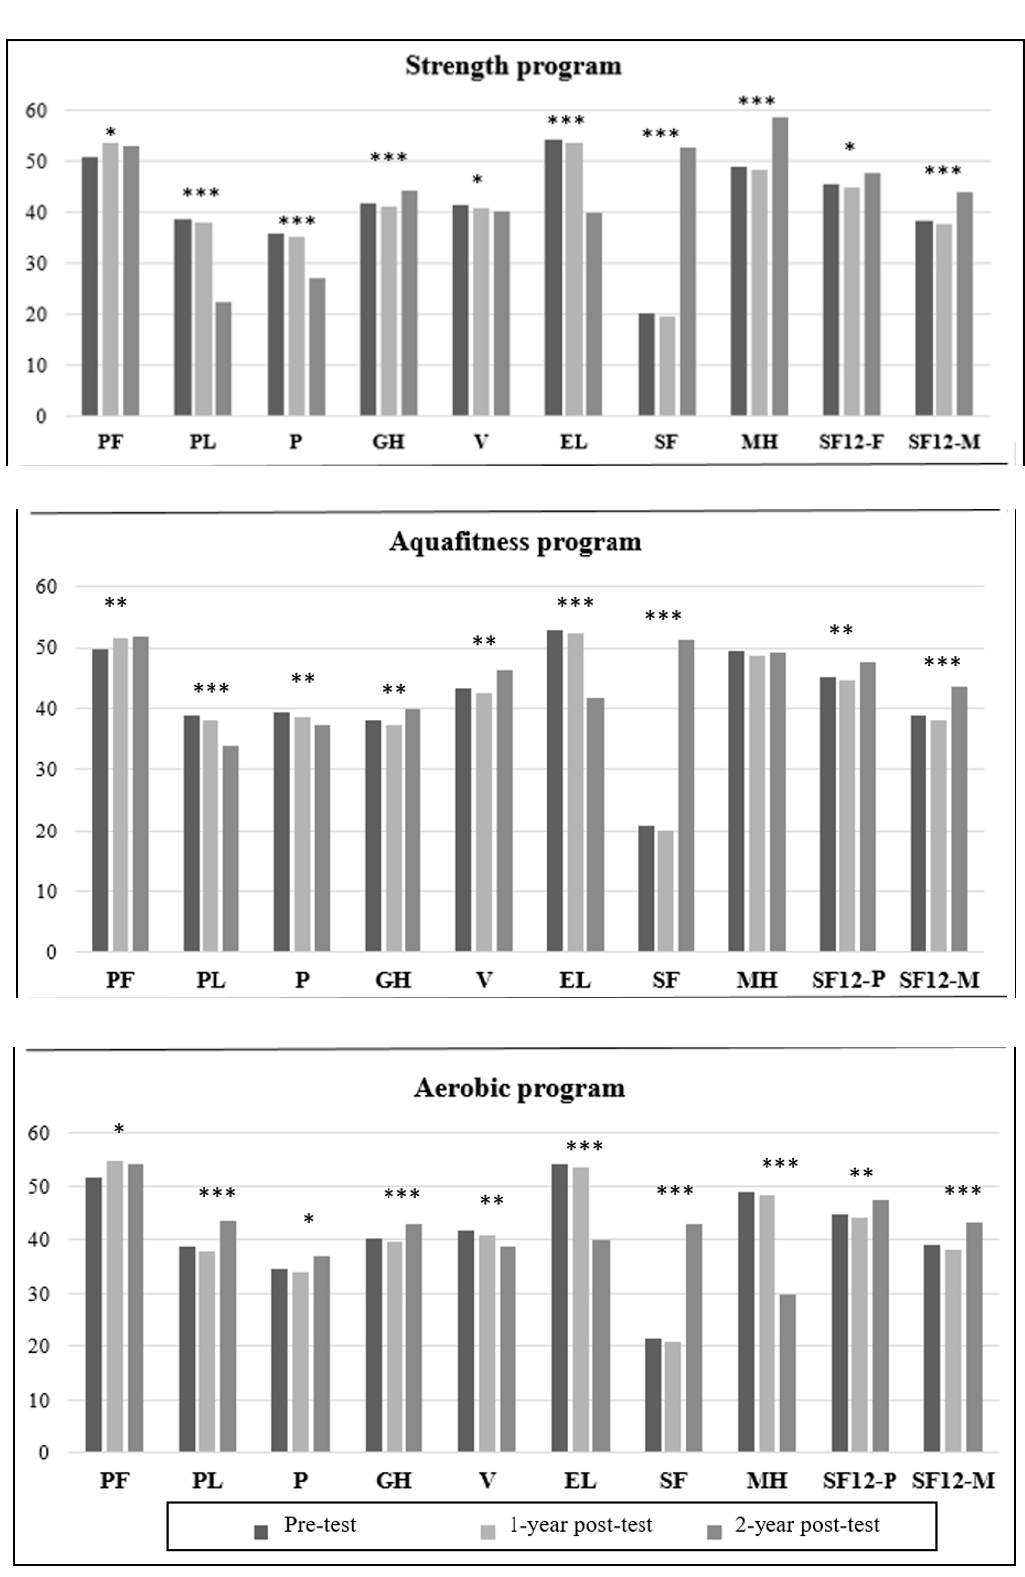
Figure 2. SF-12 survey results by intervention group. (PF: physical function; PL: physical limitations; P: pain; GH: general health; V: vitality; EL: emotional limitations; SF: social function; MH: mental health; SF12-P:SF12 physical component; SF12-M: SF12 mental component). Comparison between initial test vs. final test: * p < 0.05; ** p < 0.01; *** p <